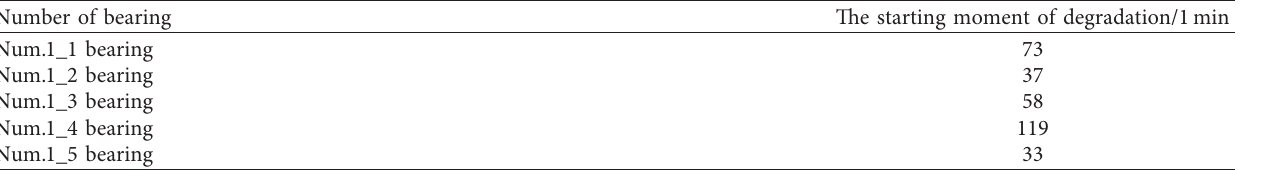
Table 2: Bearing degradation points.